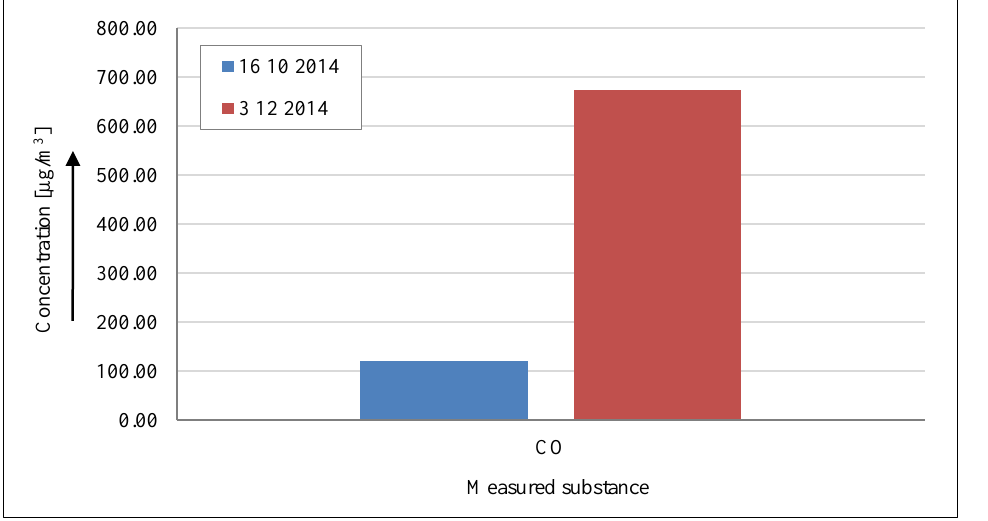
Figure 7. The concentration of CO measured